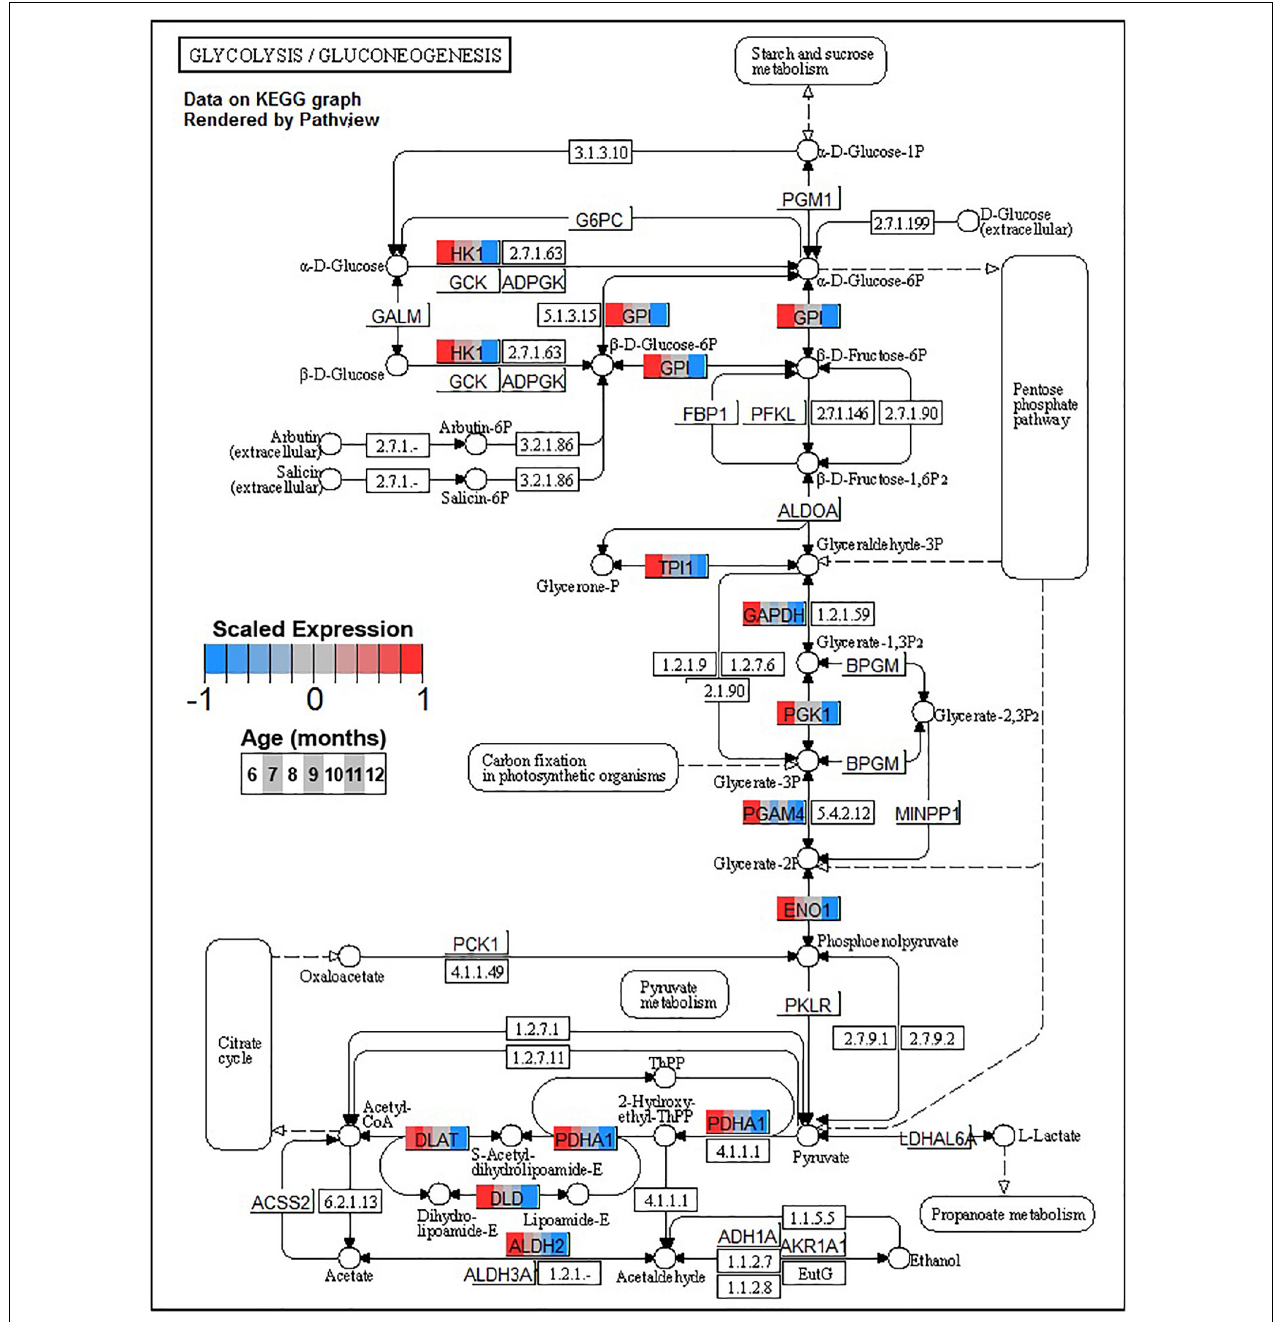
FIGURE 8 | Expression of orthologs annotated for the Kyoto Encyclopedia of Genes and Genomes (KEGG) glycolysis and gluconeogenesis (ko00010) pathway present in pleural ventral caudal sensory neuron (PVC) expression clusters with decreasing trend (P4 and P5). Each node of the pathway diagram represents an ortholog assigned to an Aplysia californica transcript. Nodes are divided into seven colored sections, from left to right, ages 6 to 12 months. Node sections are colored according to their mean centered and variance scaled expression, together representing the expression trends of each node across the aging process. Nodes that are not colored were absent from the gene sets of expression clusters P4 and P5. Pathway enrichment demonstrates broad downregulation in glucose metabolism with age including pathways involved in synthesis of acetyl-CoA from pyruvate, which feeds into the TCA